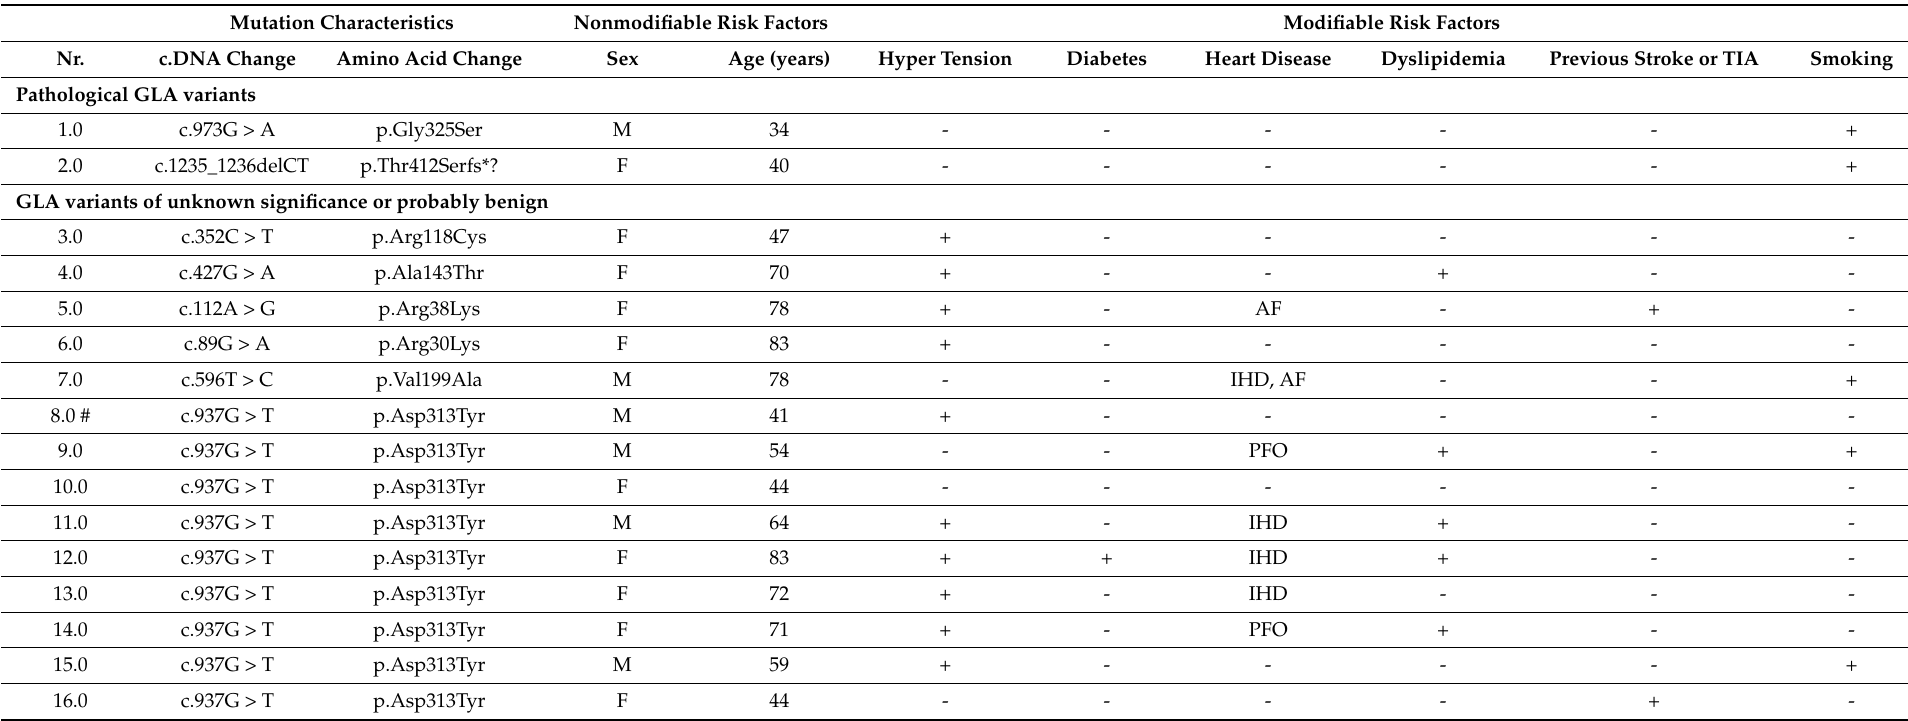
Table 2. The major risk factors for ischaemic stroke in index